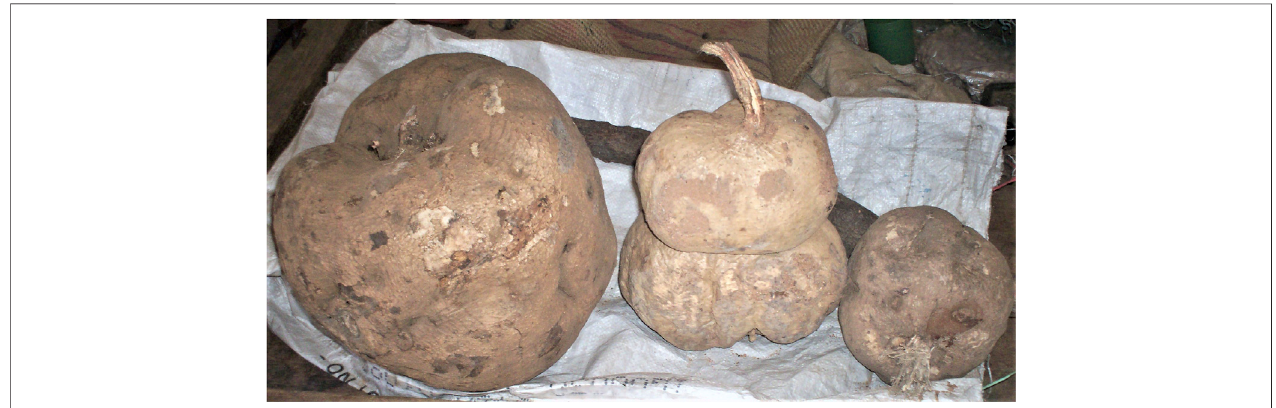
FIGURE4| “ Puerariatuberosa (Willd.)DC.VidariKand,PatalKumrha ” ,byRaviUpadhyay,https://indiabiodiversity.org/observation/show/269544,licensed under CC BY 3.0).